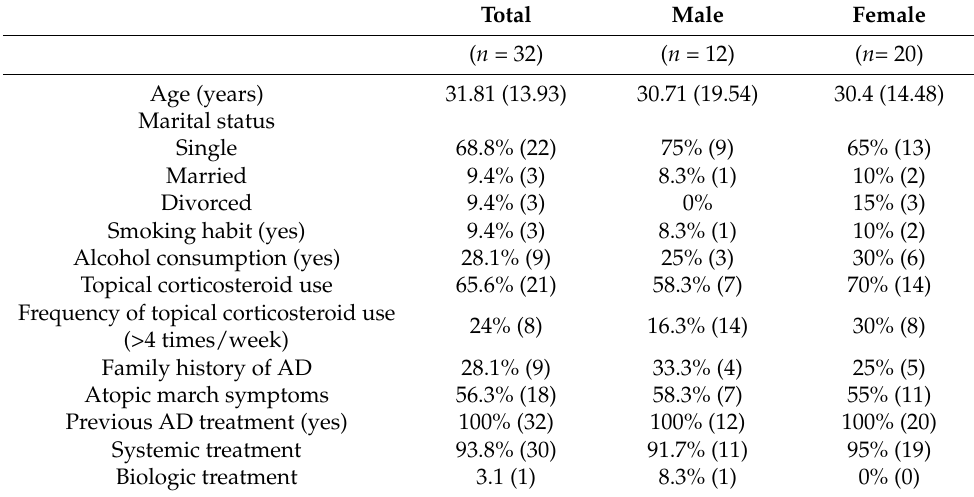
Table 1. Sociodemographic and clinical characteristics at baseline.